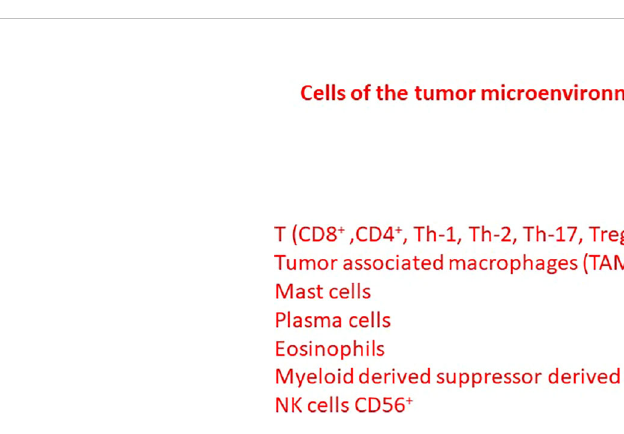
FIGURE 1 Different cells of the tumor microenvironment involved in the pathogenesis and tumor progression of classical Hodgkin